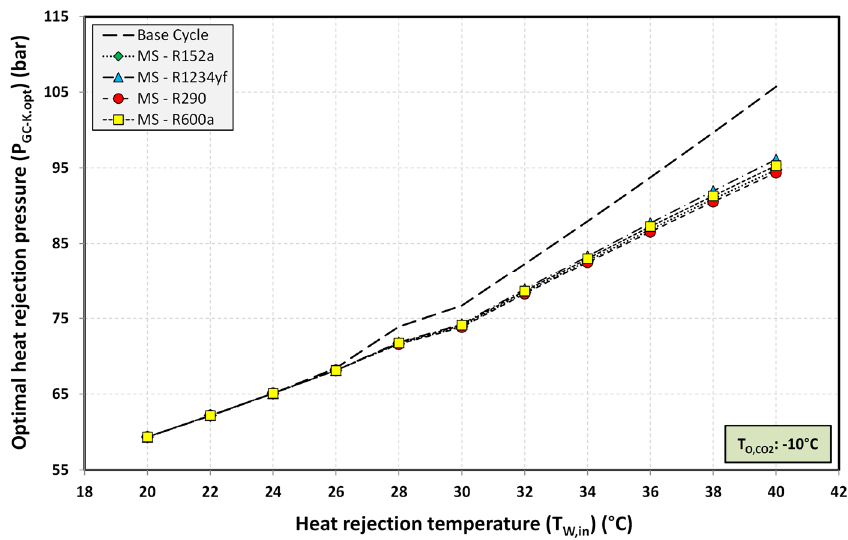
Figure 10. Optimum heat rejection pressure at different heat rejection temperatures.